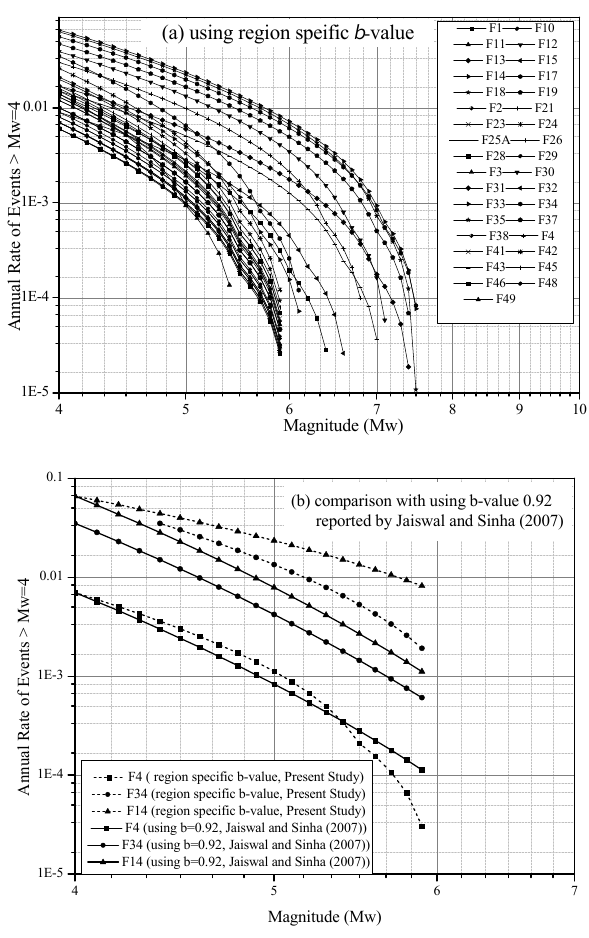
Figure 7. Fault recurrence relations (a) using b-value calculated in present study (b) comparison with using b-value 0.92 reported by Jaiswal and Sinha (2007) for some selected faults.